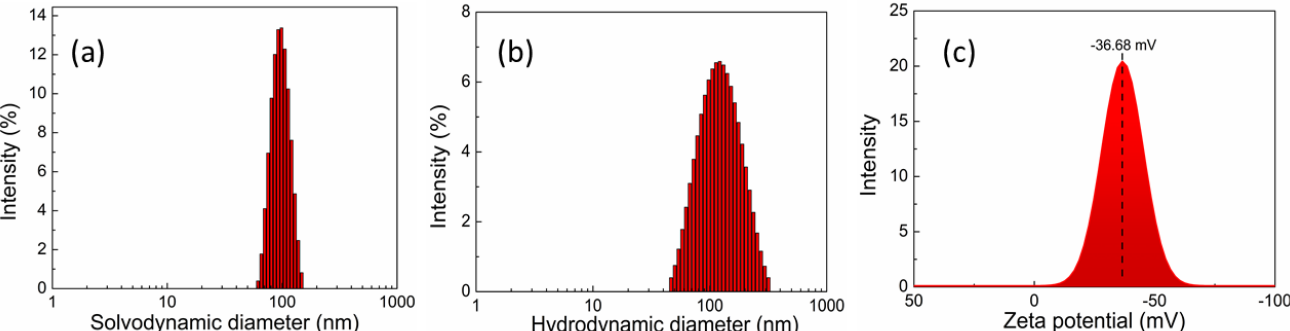
Figure 4. ( a ) The size of oleic-functionalized UCNPs measured in hexane and ( b ) the hydrodynamic size of UCNPs surface functionalized by polyacrylic acid measure in in PBS buffer (1 × ) at pH 7. ( c ) The zeta potential of UCNPs surfaced functionalized by polyacrylic acid and measured in PBS buffer at pH 7.